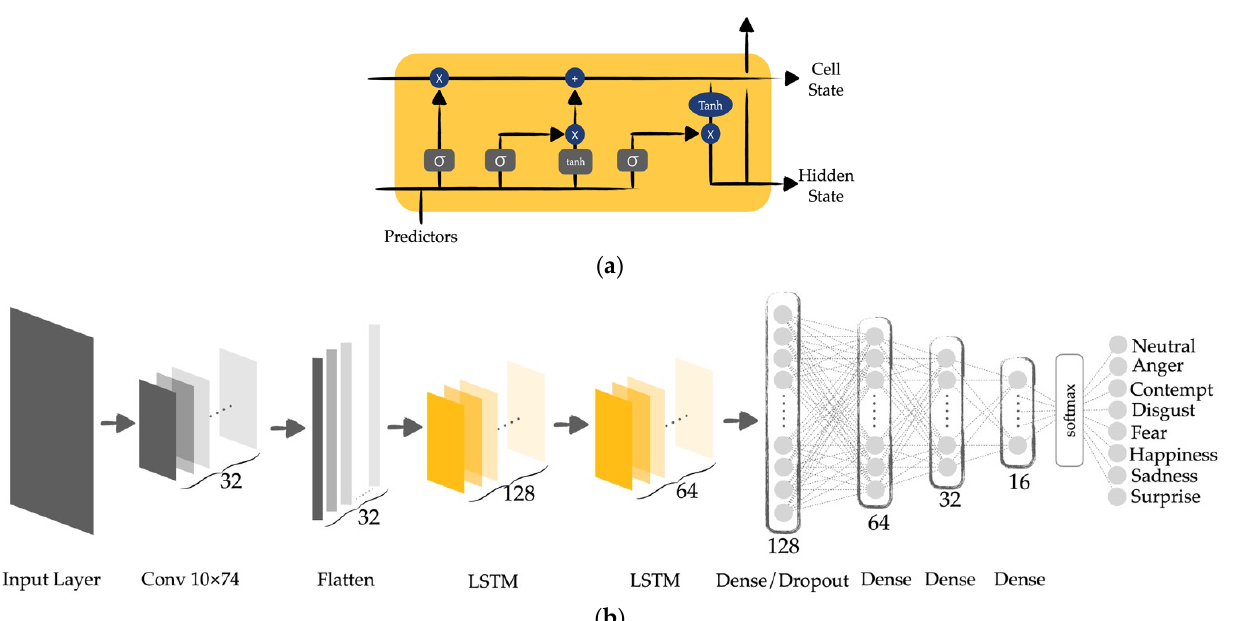
Figure 12. ( a ) LSTM components; ( b ) machine learning architecture.